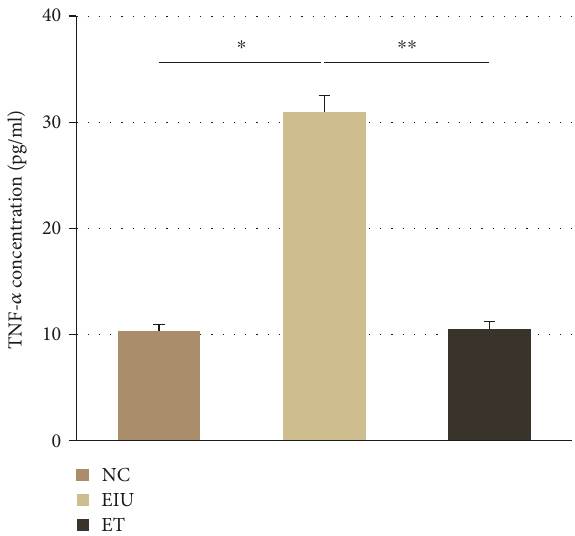
Figure 3: Expression of TNF- α in aqueous humor. All data shown as mean ± standard deviation ( n = 10 ). ∗ p < 0 05 the EIU group versus the NC group; ∗∗ p < 0 05 the ET group versus the EIU